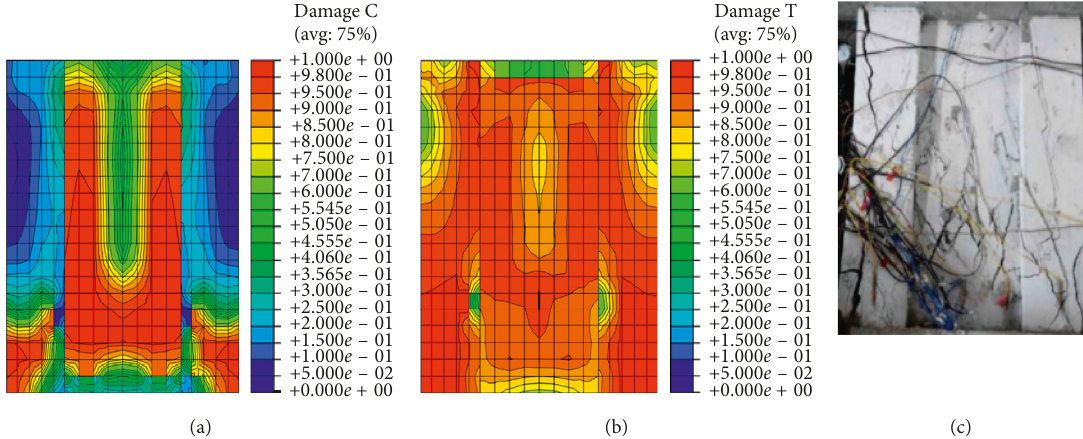
Figure 8: Predicted and test concrete damage of specimen W1-a. (a) Concrete compressive damage. (b) Concrete tensile damage. (c) Test